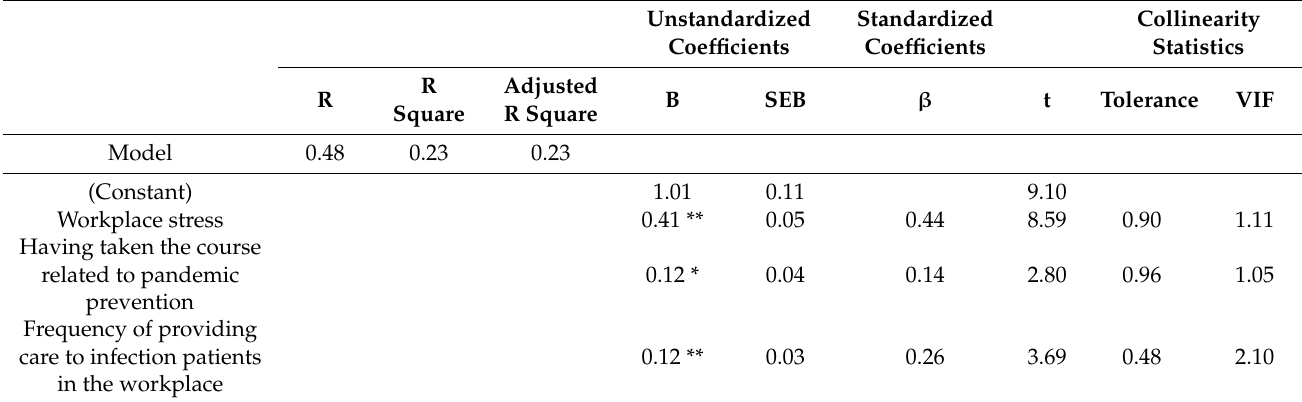
Table 5. Factors affecting novice nurses’ intention to stay in their current position (N =